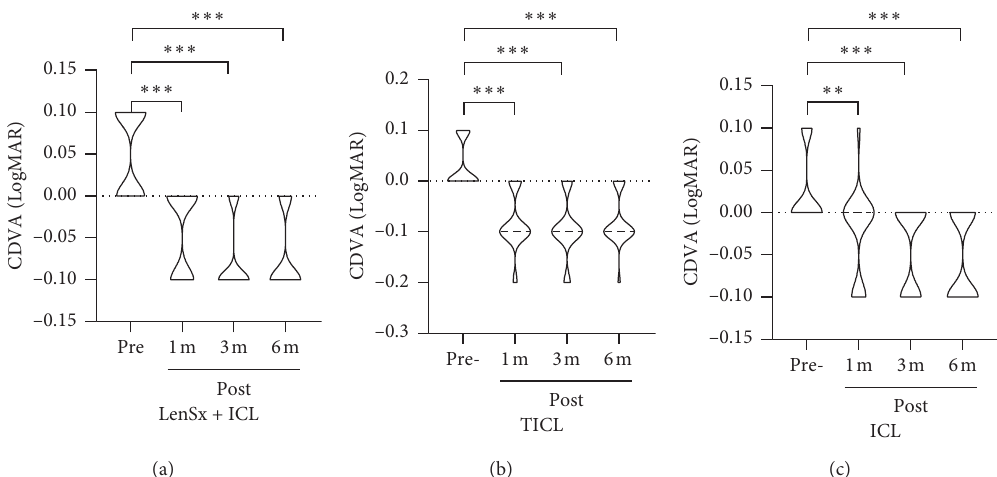
Figure 4: The LogMAR CDVA before and after surgery at 1, 3, and 6 months in three groups (the results are expressed as means ± SD, ∗∗ P < 0 . 01, and ∗∗∗ P < 0 .